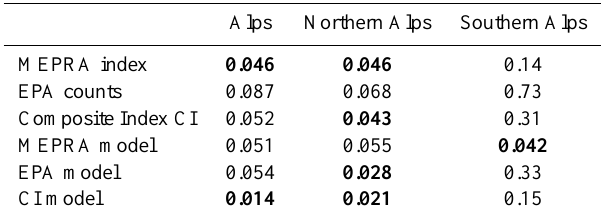
Table 1. Spearman rank correlation test ( p -values) for the 1958– 2009 period. Bold values indicate series for which the stationarity assumption is rejected at the 95% confidence